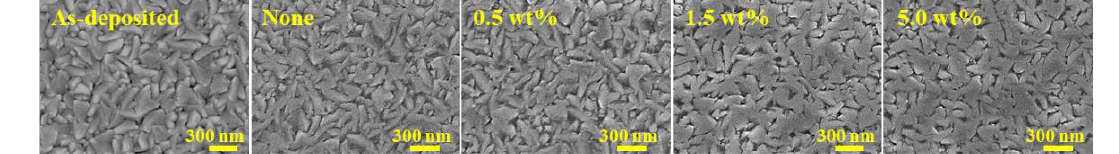
Figure 4. ( a ) Dissolution rates and R a values from the tungsten dipping test and ( b ) removal rates and R a values from the tungsten CMP test for various picolinic acid concentrations. 4. Conclusions In order to remove the topography of the tungsten surface during the CMP process, the effect of picolinic acid on tungsten dissolution was studied. First, the adsorption be- havior of picolinic acid on tungsten oxide was analyzed using the Langmuir and Freun- dlich model equations. The adsorption of picolinic acid on tungsten oxide fit well with the Langmuir model and saturated at 1.5 wt%. The removal and dissolution rates were tested at selected picolinic acid concentrations and were shown to decrease with picolinic acid concentration until saturation at 1.5 wt%, which is in good agreement with the adsorption behavior. To analyze the surface topography of each sample, AFM and SEM were used. Tungsten grains were well removed with 1.5 wt% picolinic acid because the valleys of tungsten did not dissolve due to the adsorption of picolinic acid, while the tops were pol- ished until the entire surface flattens, resulting in minimizing the tungsten topography below 10 nm. The experimental results in this study are expected to play a role in amelio- rating defects and enhancing the buffing efficiency during the tungsten CMP process for next generation semiconductor process. Supplementary Materials: The following supporting information can be downloaded at: www.mdpi.com/article/10.3390/app12031227/s1, Table S1: Detailed CMP process conditions; Figure S1: Hydrodynamic diameters of SiO 2 abrasive as a function of the concentration of picolinic acid; Table S2: Hydrodynamic diameters and Zeta potential of SiO 2 abrasive as a function of the concen- tration of picolinic acid.